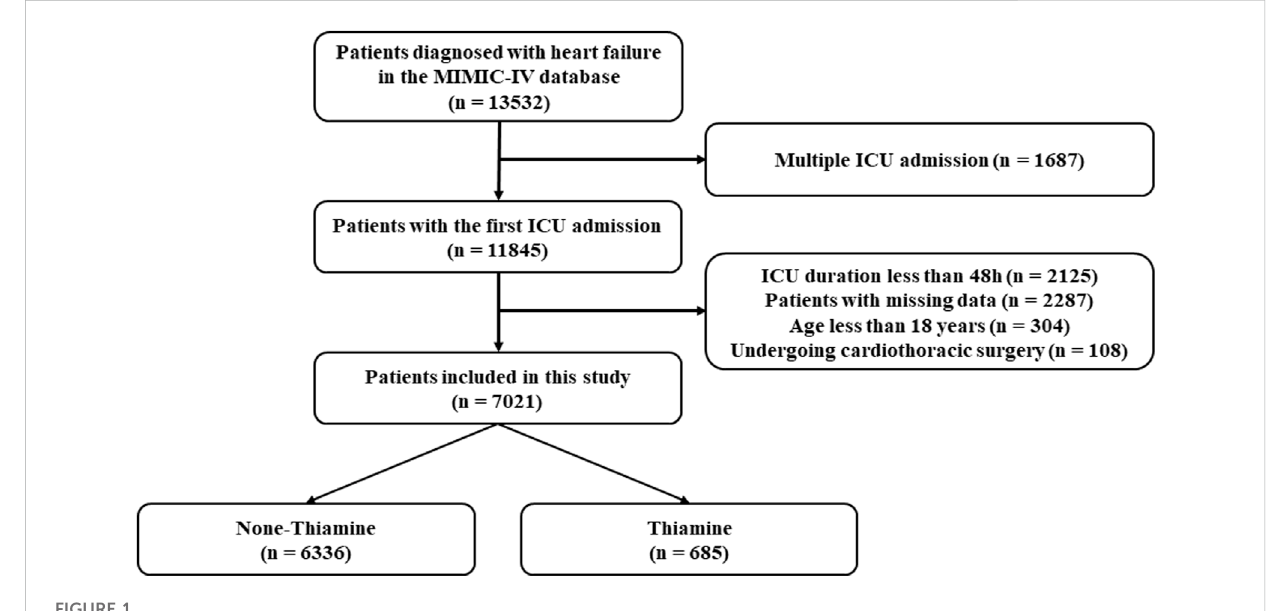
FIGURE 1 Inclusion and exclusion fl owchart of the